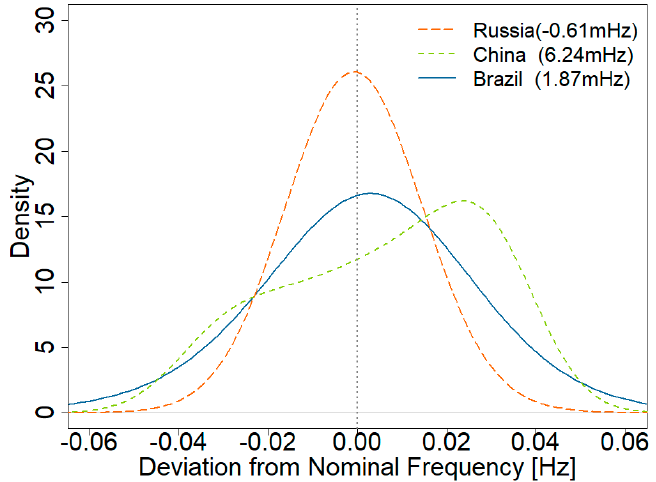
Figure 14. Probability distribution of power system frequency in countries not providing the time error correction in 2016. Figures in brackets denote the average frequency deviation away from the nominal frequency.